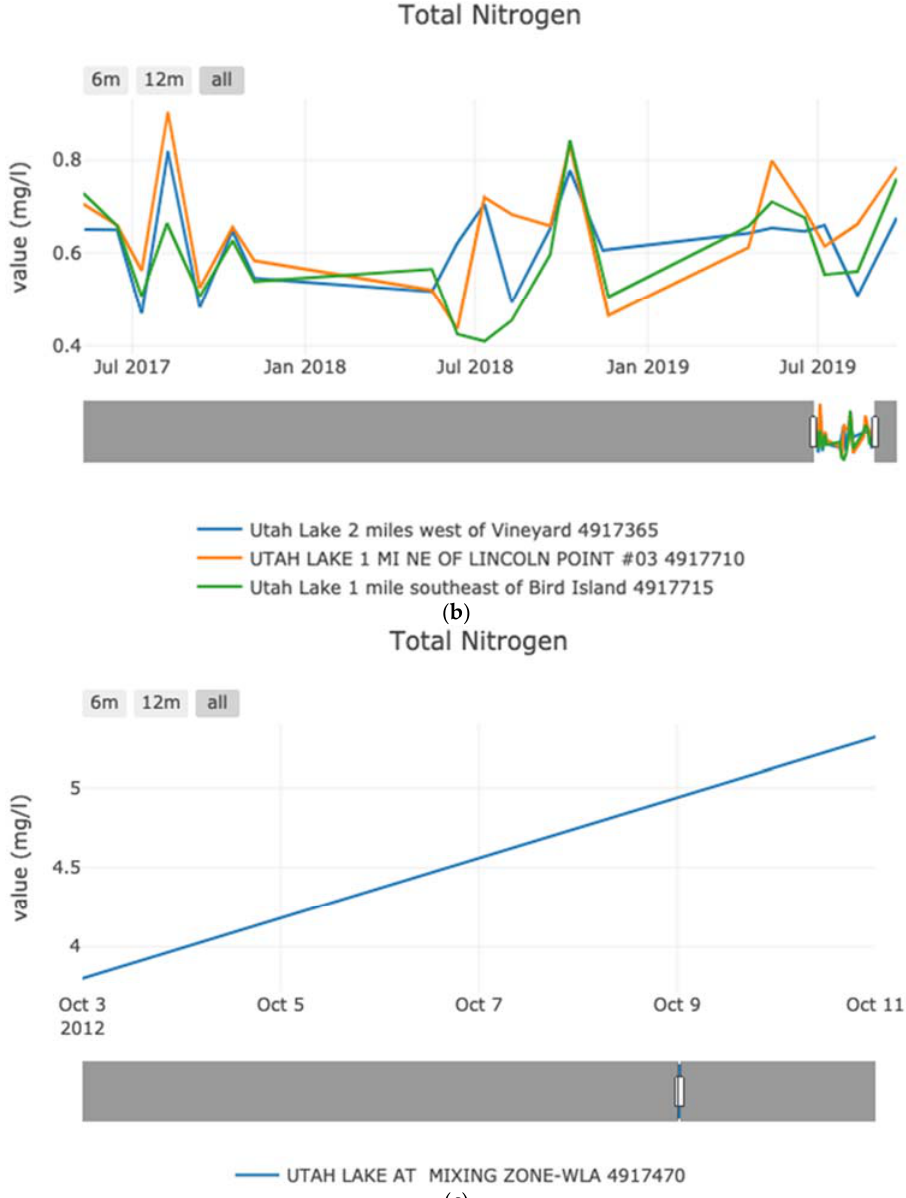
Figure 8. Utah Lake stations from AWQMS with Total Nitrogen data of ( a ) all periods; ( b ) part of the period; ( c ) only two samples.